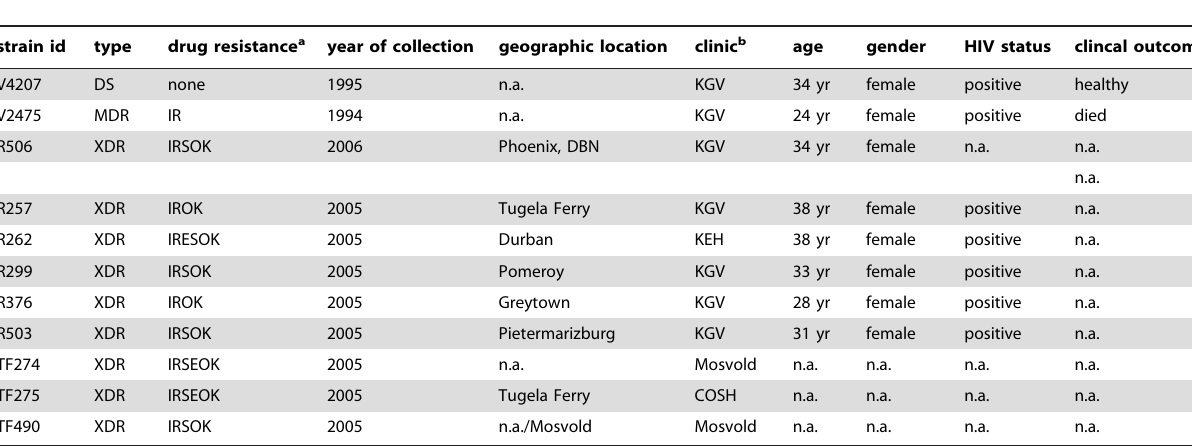
Table 1. Epidemiological data on strains sequenced in this